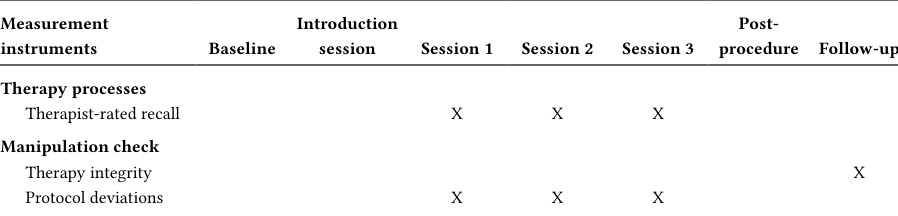
Overview of Therapist/Observer Instruments per Time